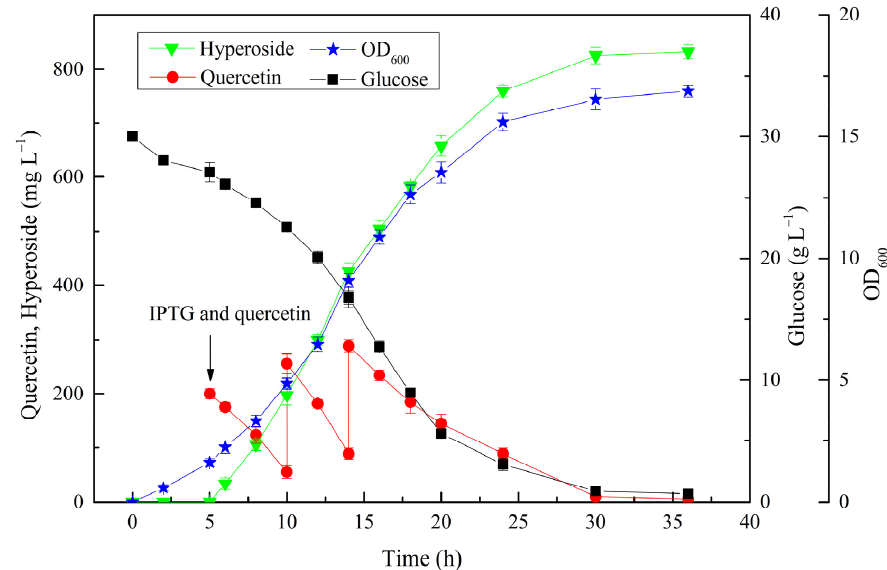
Figure 7. Hyperoside production by substrate-fed batch fermentation.